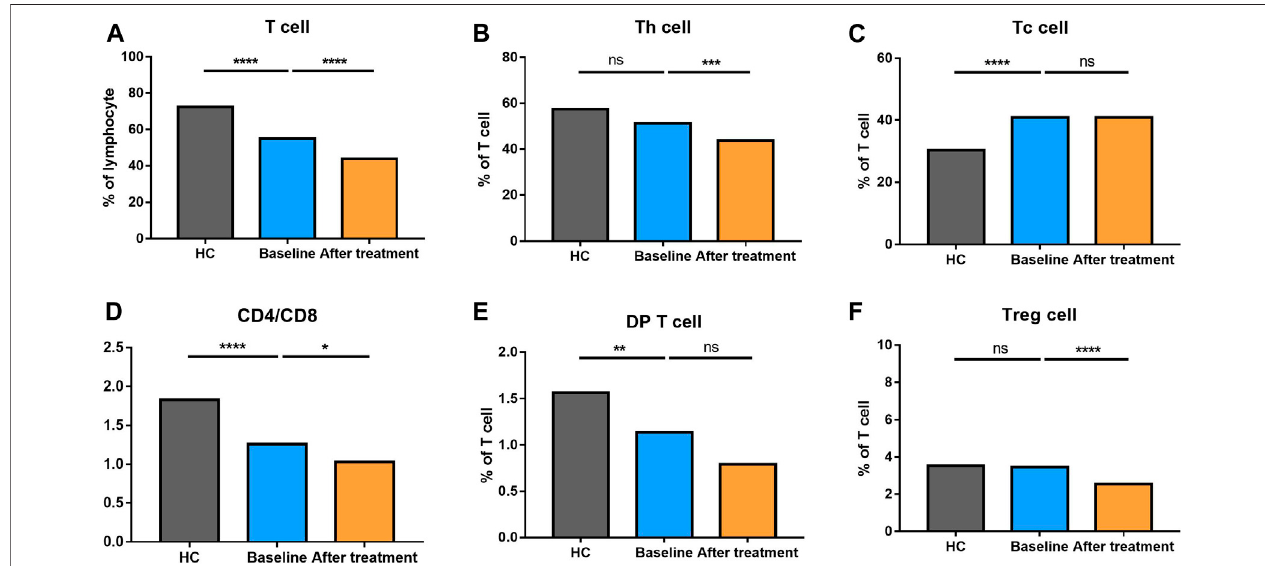
FIGURE 2 | Altered expression of T cell subsets in AS patients after treated with secukinumab. The proportion of T cell subsets measured by fl ow cytometry at baseline and after receiving secukinumab in AS patients. ns, not signi fi cant; *, p < 0.05; **, p < 0.01; ***, p ≤ 0.001; ****, p < 0.0001.